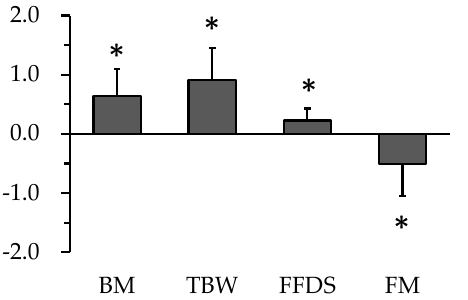
Figure 4. Change in body composition during carbohydrate loading. Values are expressed as mean ± SD of delta value (post-loaded value − pre-loaded value). BM, body mass; TBW, total body water; FFDS, fat-free dry solid; FM, fat-mass. * Significant ( p < 0.05) difference between pre-loaded value and post-loaded value.